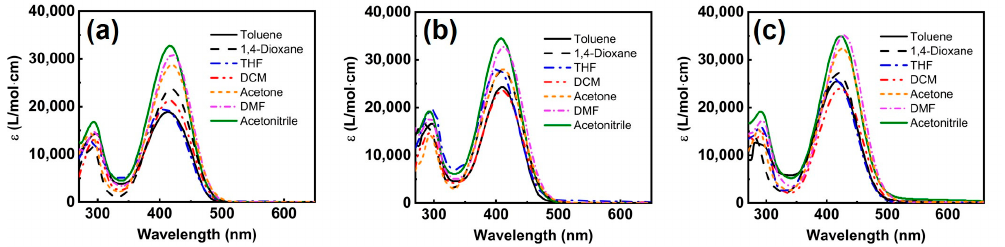
Figure 1. Absorption spectra of o -DBCNPy ( a ), m -DBCNPy ( b ), and p -DBCNPy ( c ) in 1 × 10 − 5 M solutions (THF, tetrahydrofuran; DCM, dichloromethane; DMF, N , N -dimethylformamide).